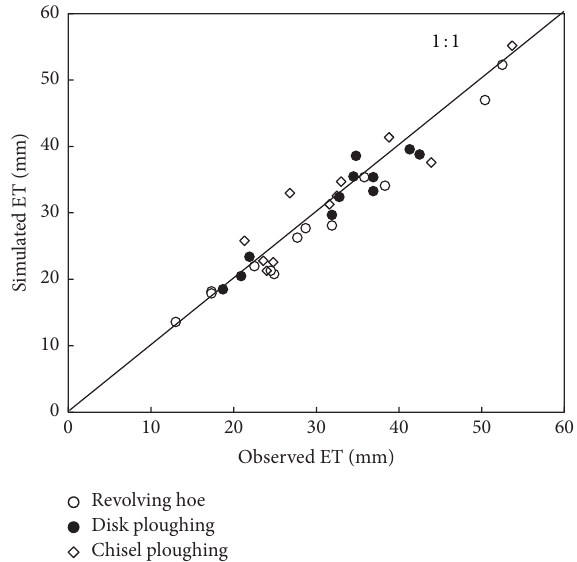
Figure 2: Observed and simulated evapotranspiration determined fromdualcropcoefficientrelatedtodegree-days,forbeancropsown in different soil tillage systems